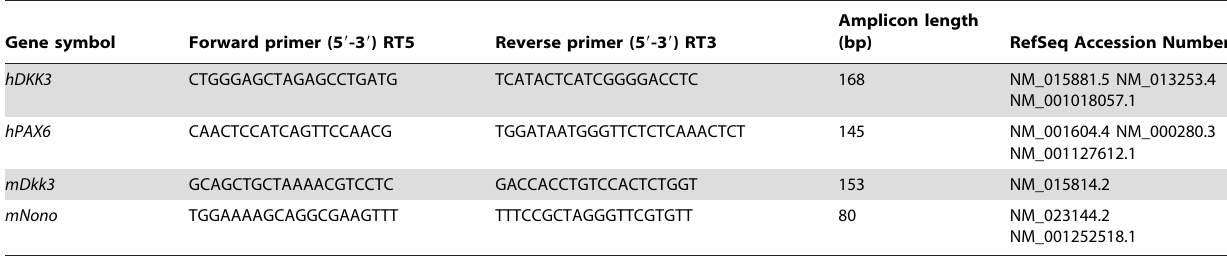
Table 1. Primers for